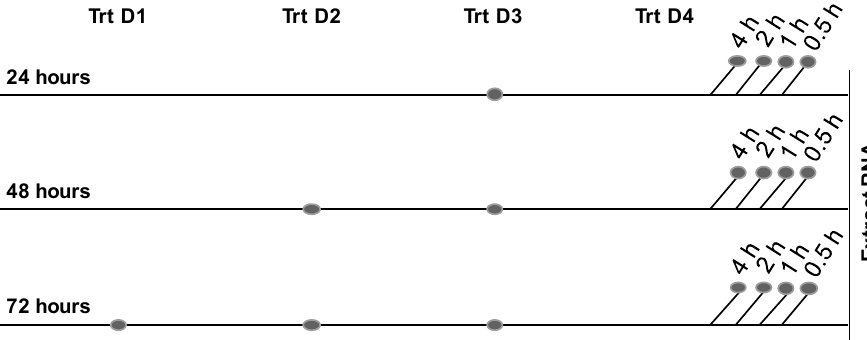
Figure 5. Protocol for morphine treatment. At confluence, hCMEC/D3 cells were incubated in the absence or presence of morphine (0.1 µM) for 24, 48, or 72 h (Trt D1, Trt D2, etc. ), during which time morphine was re-administered every 24 h to maintain drug concentration. Untreated cells received an equivalent volume of media. At the indicated time points after the final addition of morphine, RNA was extracted. The dots indicate the points in time that morphine was added to the culture. The 24, 48, and 72 h indicate the total time of morphine exposure, and the noted time increments indicate the duration elapsed between the final morphine addition and RNA extraction.